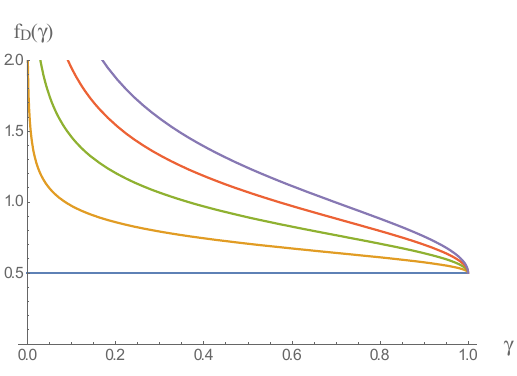
Figure 10 . The functions f D ( (cid:13) ) from (5.23) for D = 3 ; 4 ; 5 ; 6 ; 7 on the interval (cid:13) 2 (0 ; 1). The constant function f 3 = 1 (lowest curve) is included for reference and, moving upward in the (cid:12)gure, 2 successive curves have increasing values of D